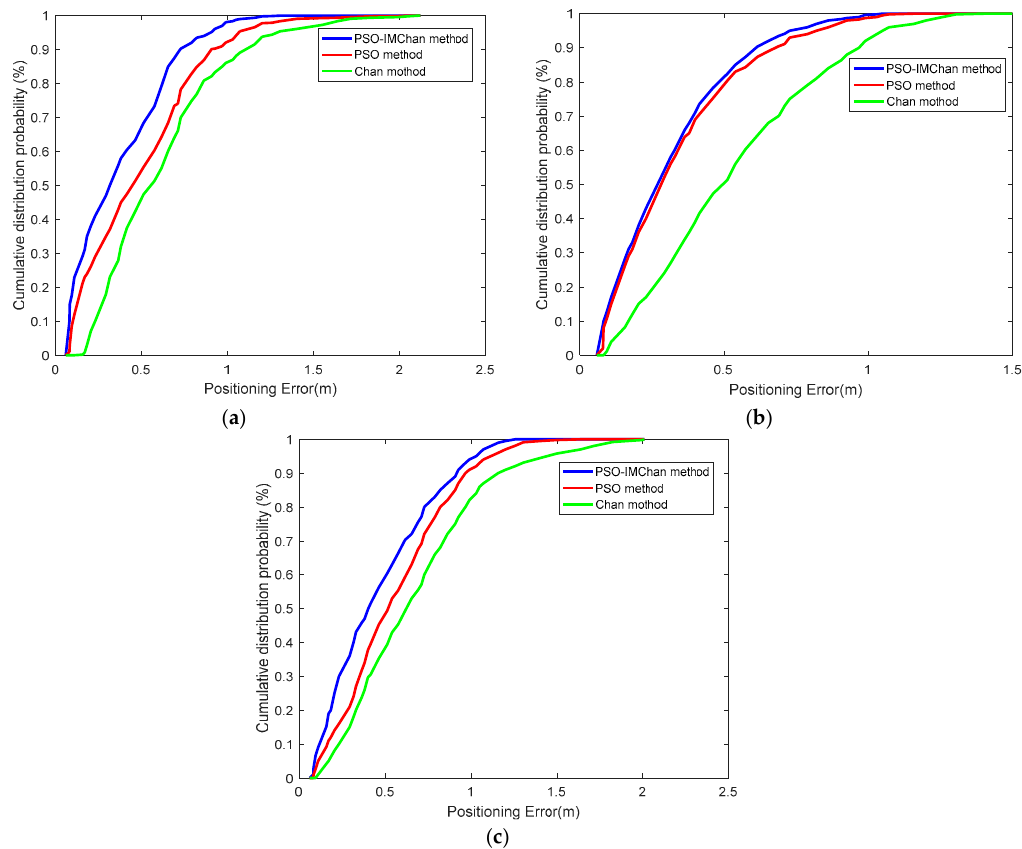
Figure 4. The CDF curves of positioning error. ( a ) 3-D positioning CDF; ( b ) horizon positioning error CDF; and ( c ) vertical positioning error CDF. Table 2. The positioning error of different scenarios (m).